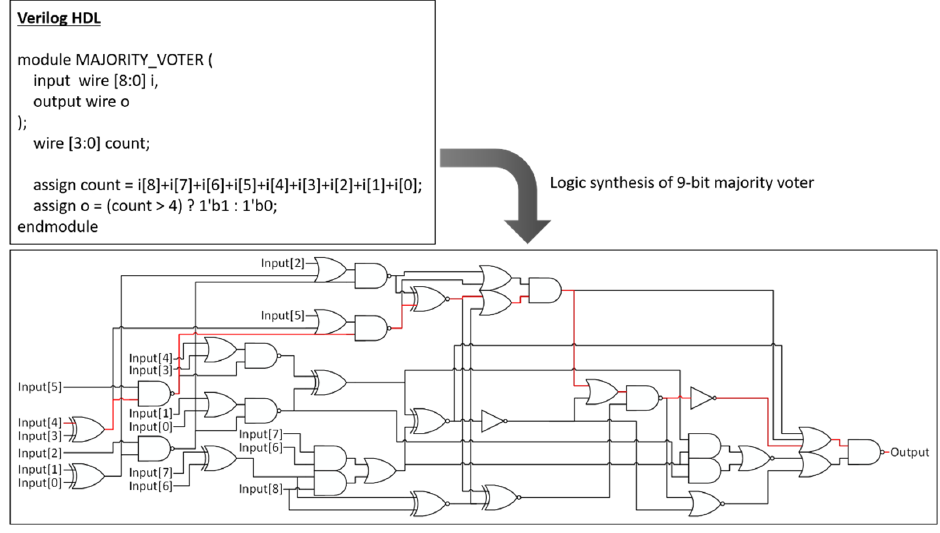
Figure 2. Example of 9-bit majority voter using a logic synthesis. Critical path is shown in red color.